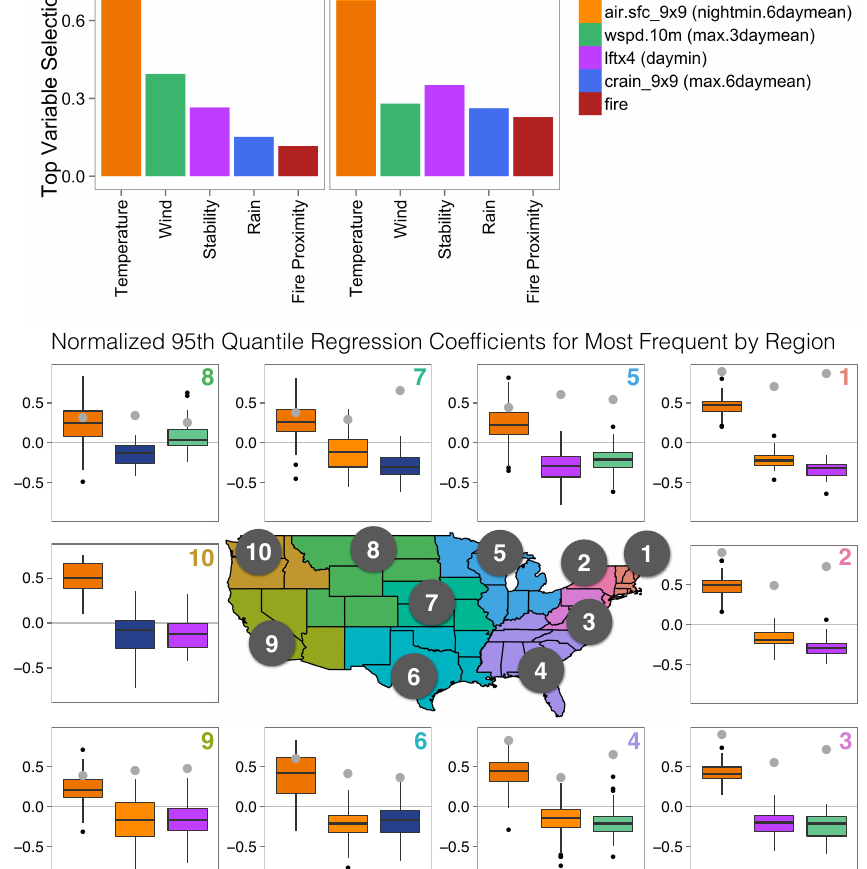
Figure 7. Same as Fig. 4 but for summer PM 2 . 5